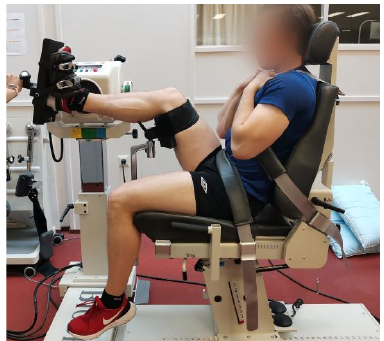
Figure 1. Testing position of ankle plantar and dorsiflexion.